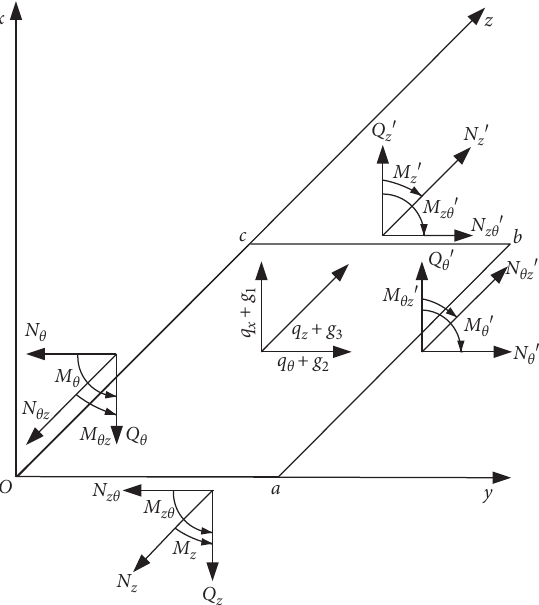
Figure 3: Force diagram of